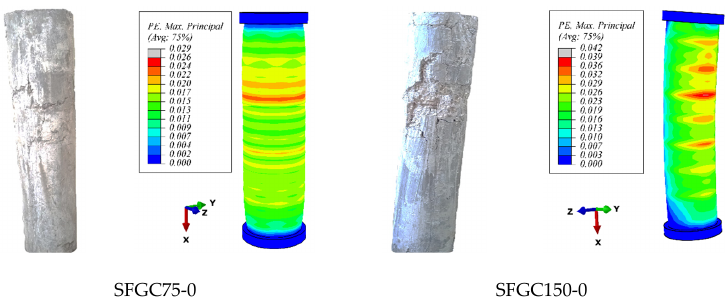
Figure 10. Overview of some GFGC and SFGC specimens after failure.